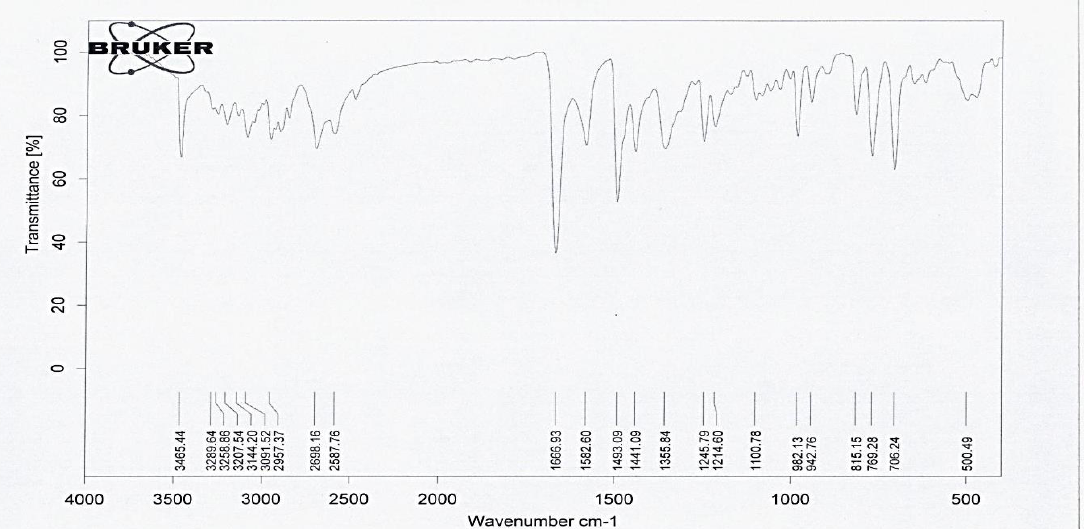
Figure 2. DSC thermogram of glyceryl monostearate .